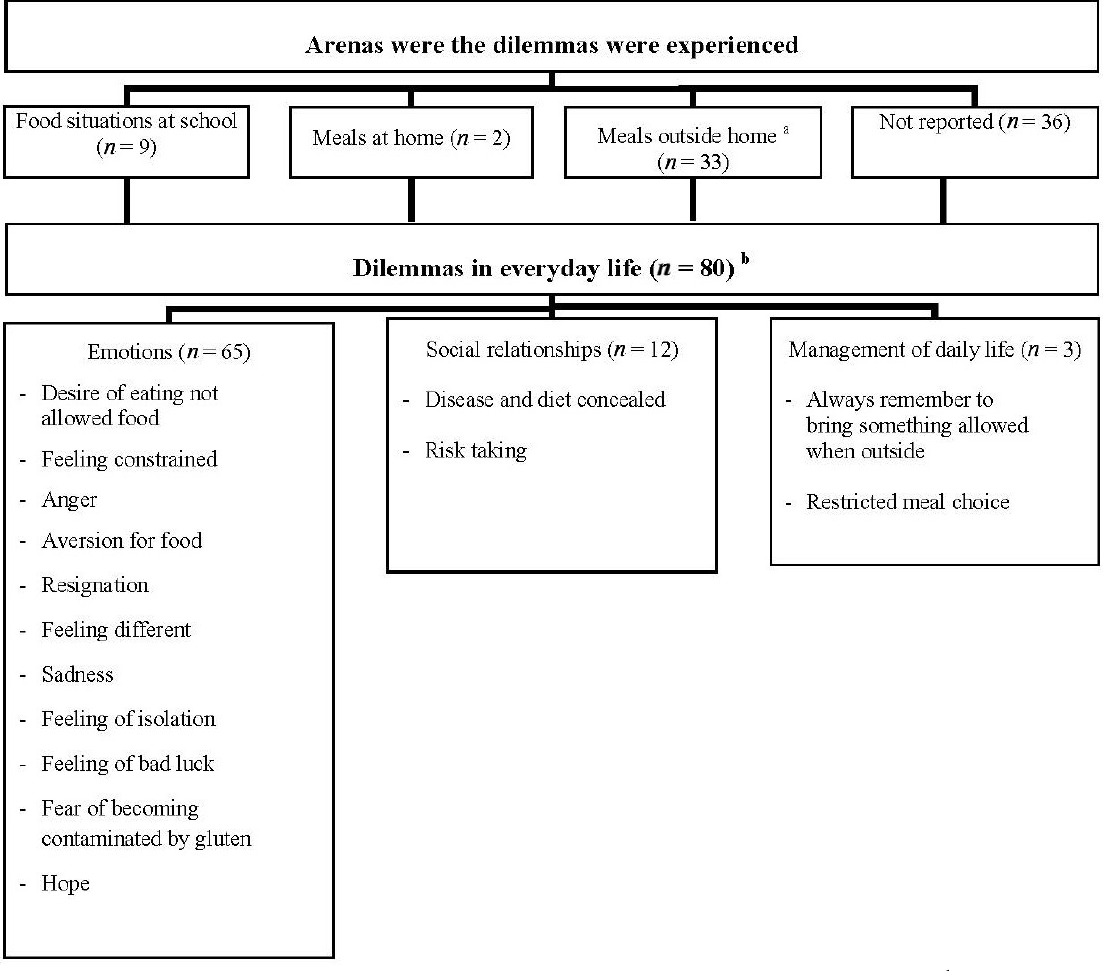
Figure 1. Lived experiences of dilemmas ( n ) in everyday life among children with celiac